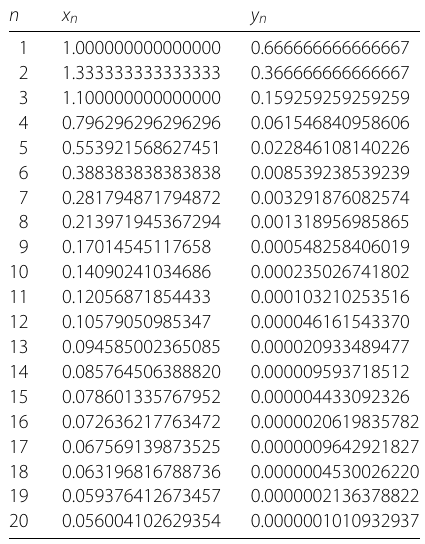
Table 2 Numerical results of { x n } and { y n } with initial x 1 = 1.0 based on (3.11)